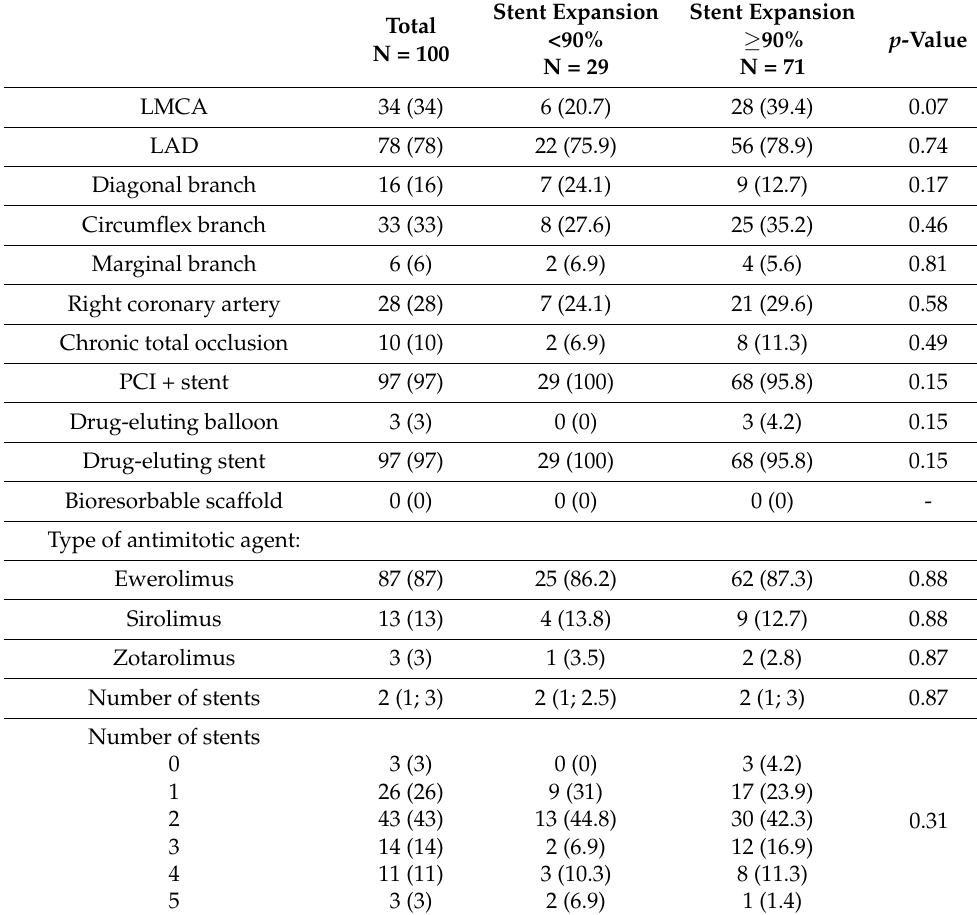
Table 3. Procedural